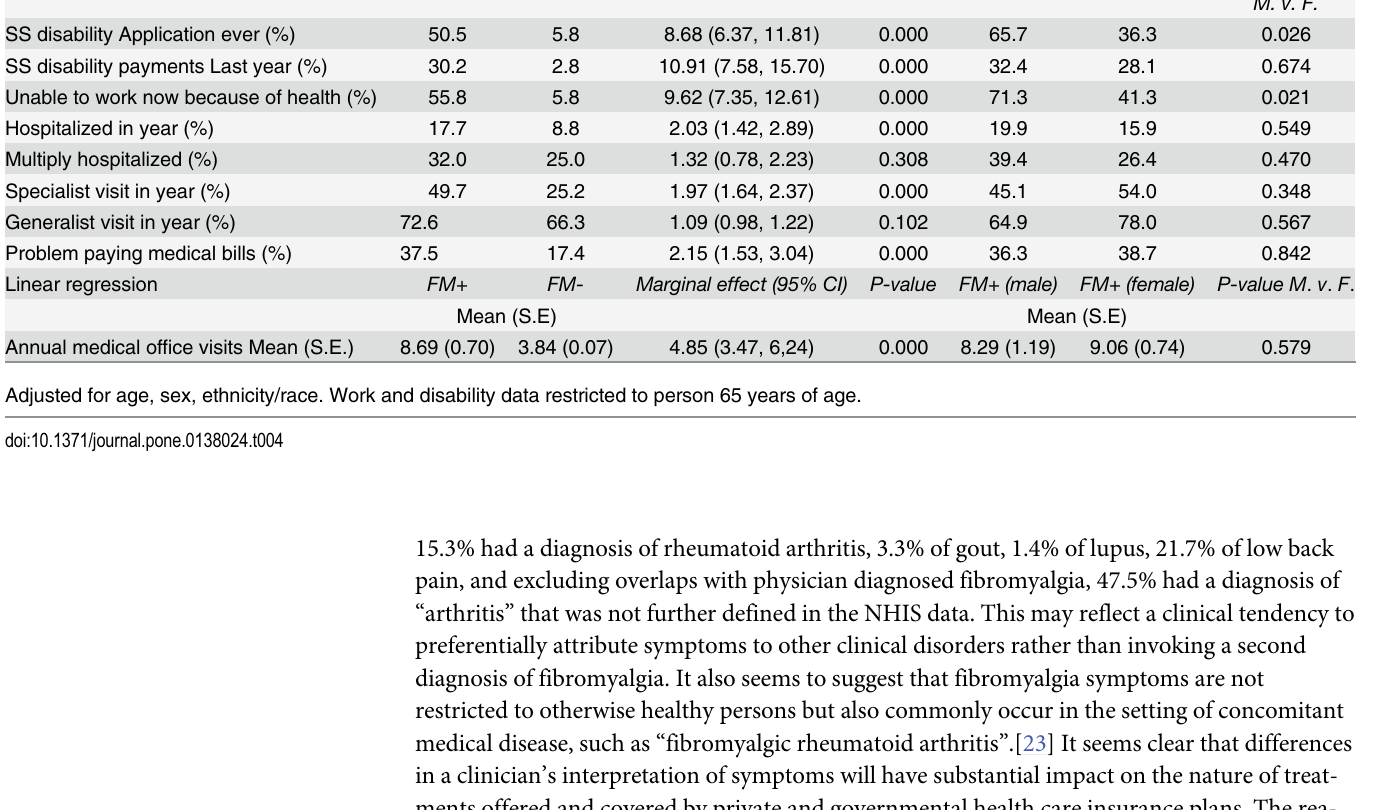
Table 4. Work disability and inpatient and outpatient utilization in persons with and without fibromyalgia in the 2012 National Health Interview Survey. Logistic regression